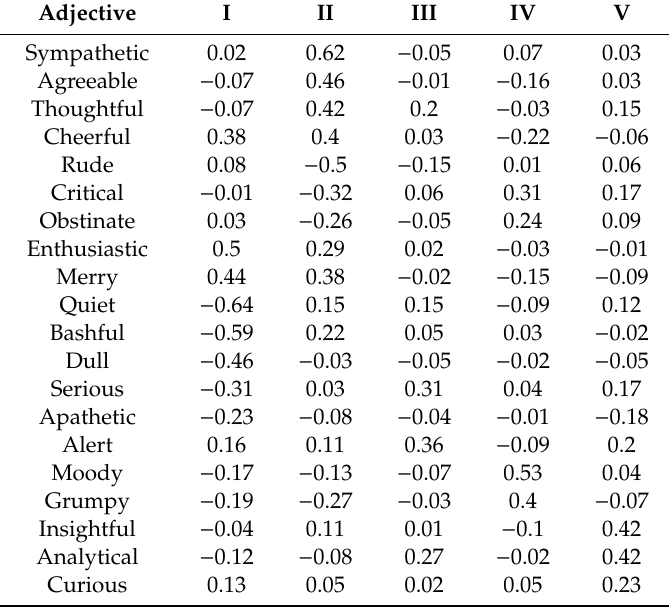
Table 1. Factor loadings of the adjectives selected in each of the five factors. Taken from